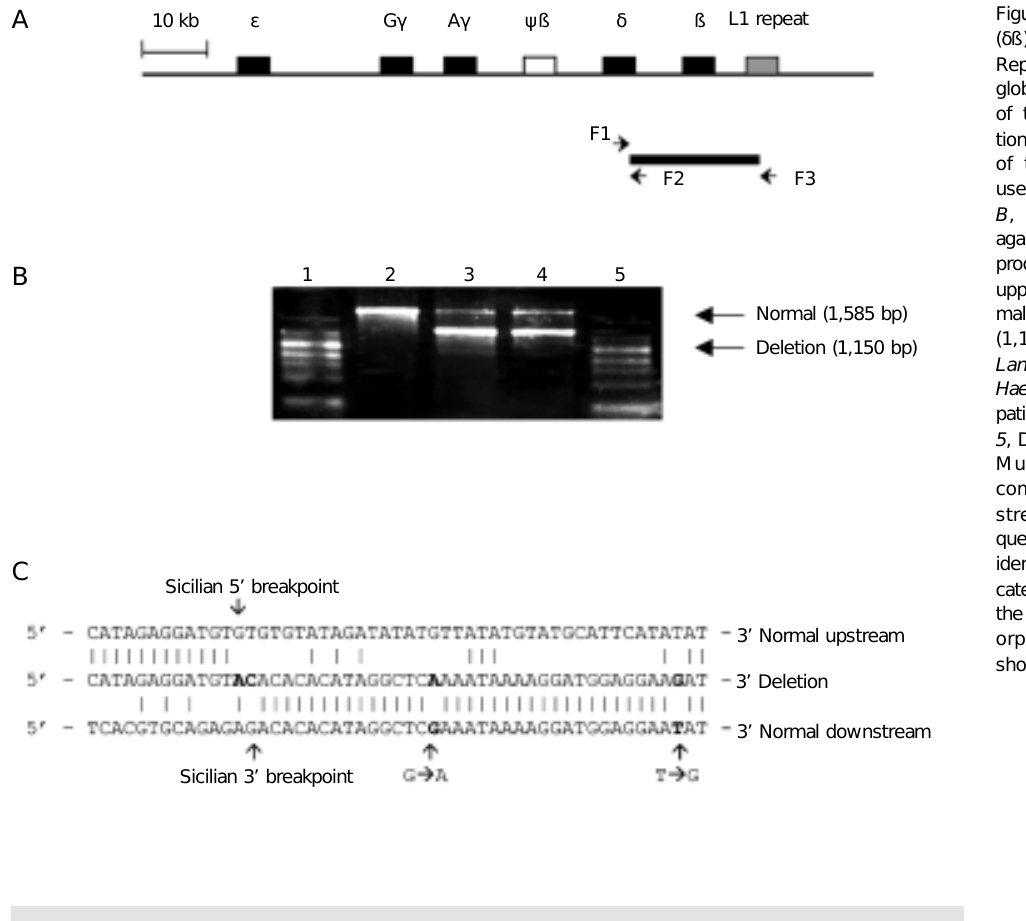
Table 1. Hematological data of the patients’ families.